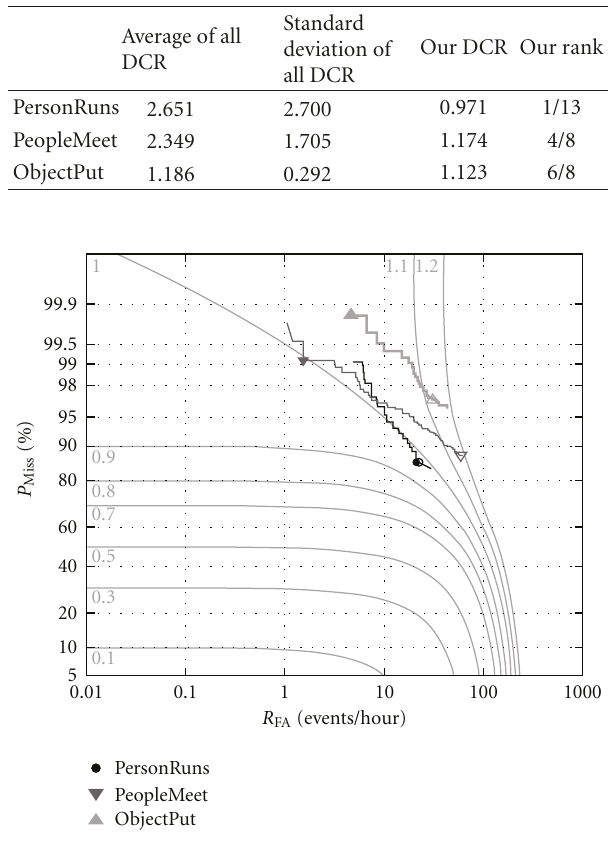
Table 5: Comparison with other systems.